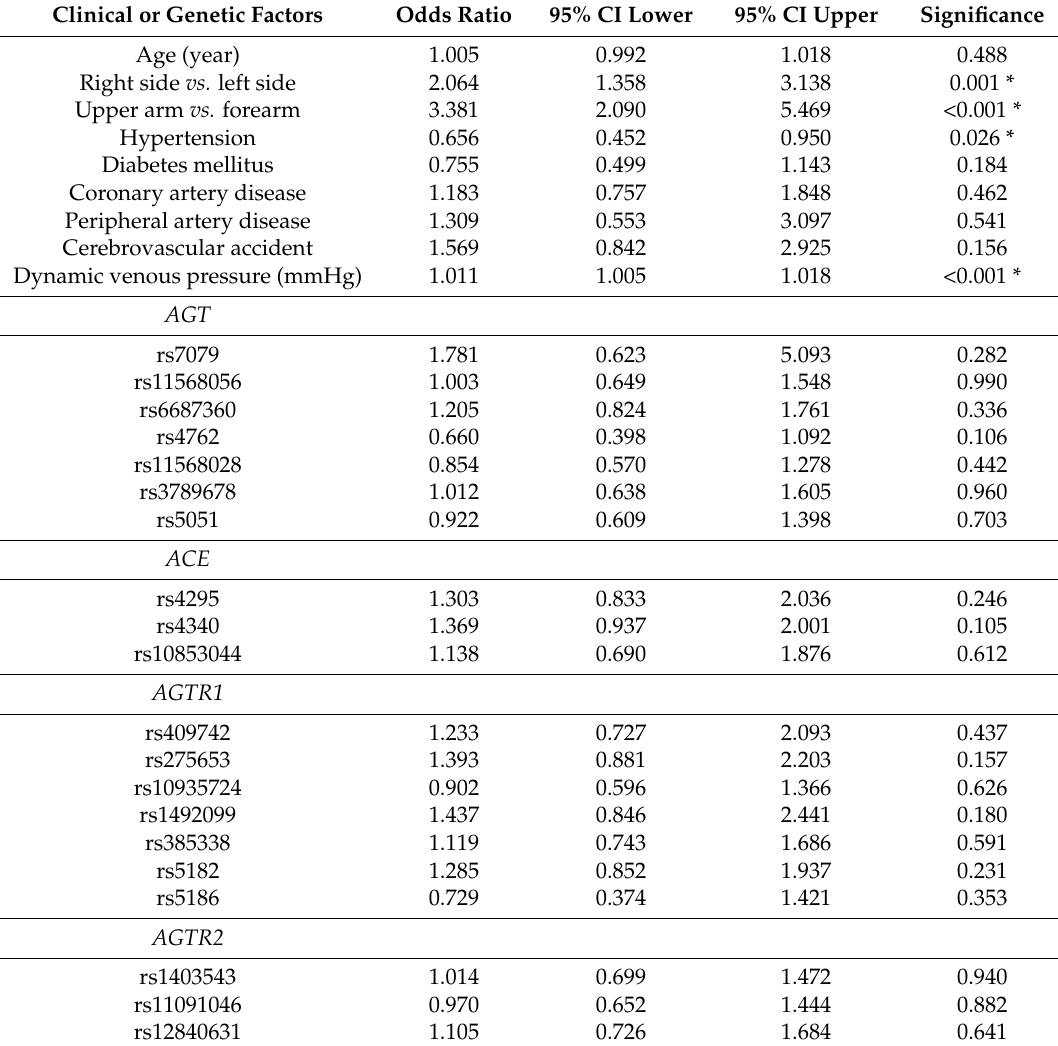
Table 3. Univariate logistic regression model of factors associated with AVF malfunction in all HD